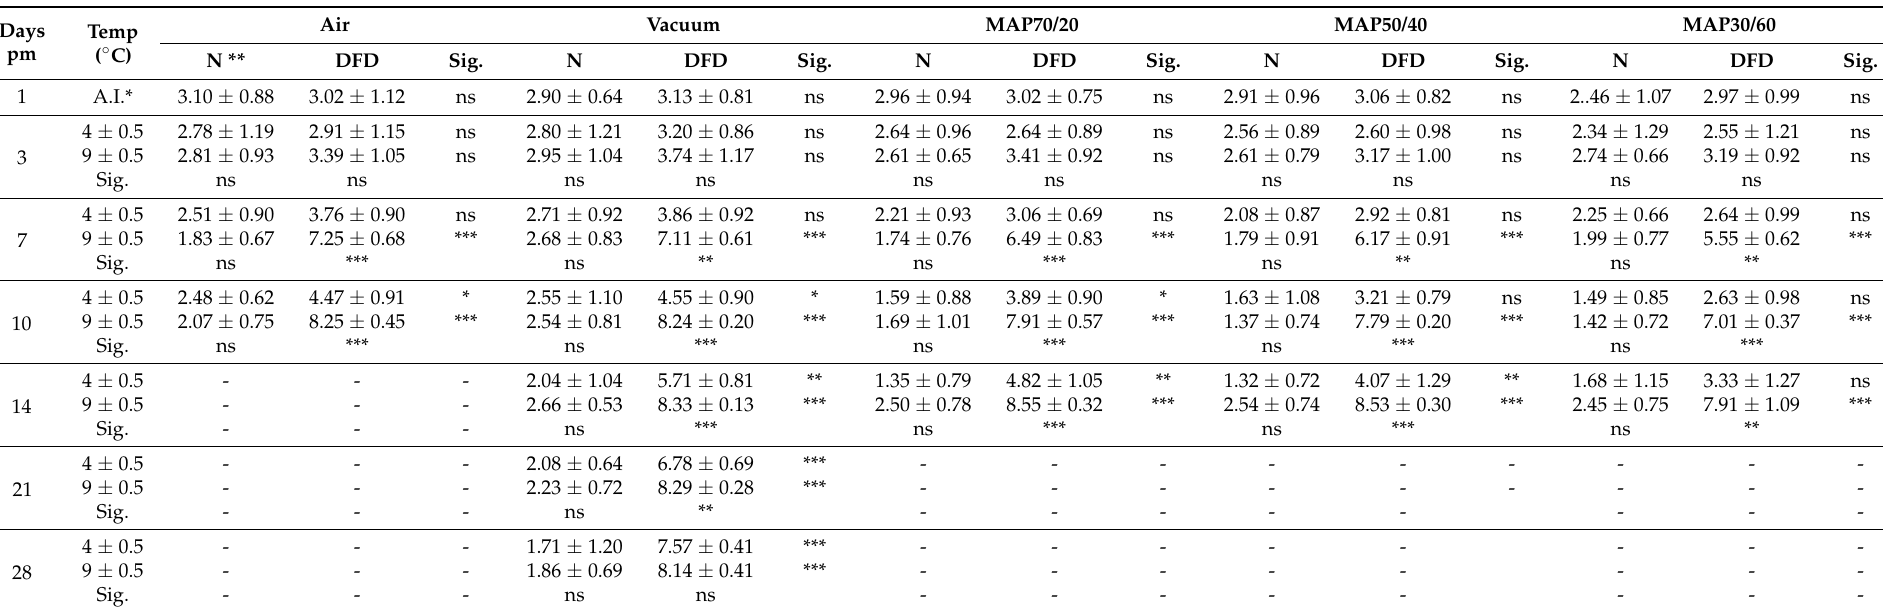
Table 2. Counts of L. monocytogenes (log CFU/g) in inoculated beef samples according to pH groups (Normal and DFD) in five different packagings and stored